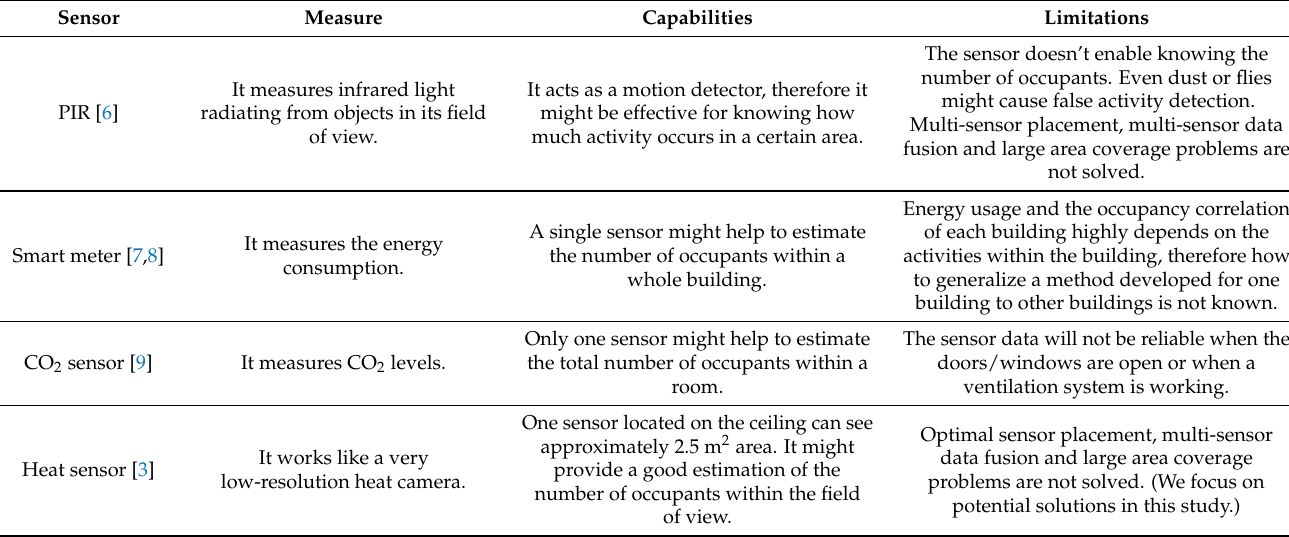
Table 1. The most frequently used occupancy prediction sensors are represented with their advantages and disadvantages when smart office applications are